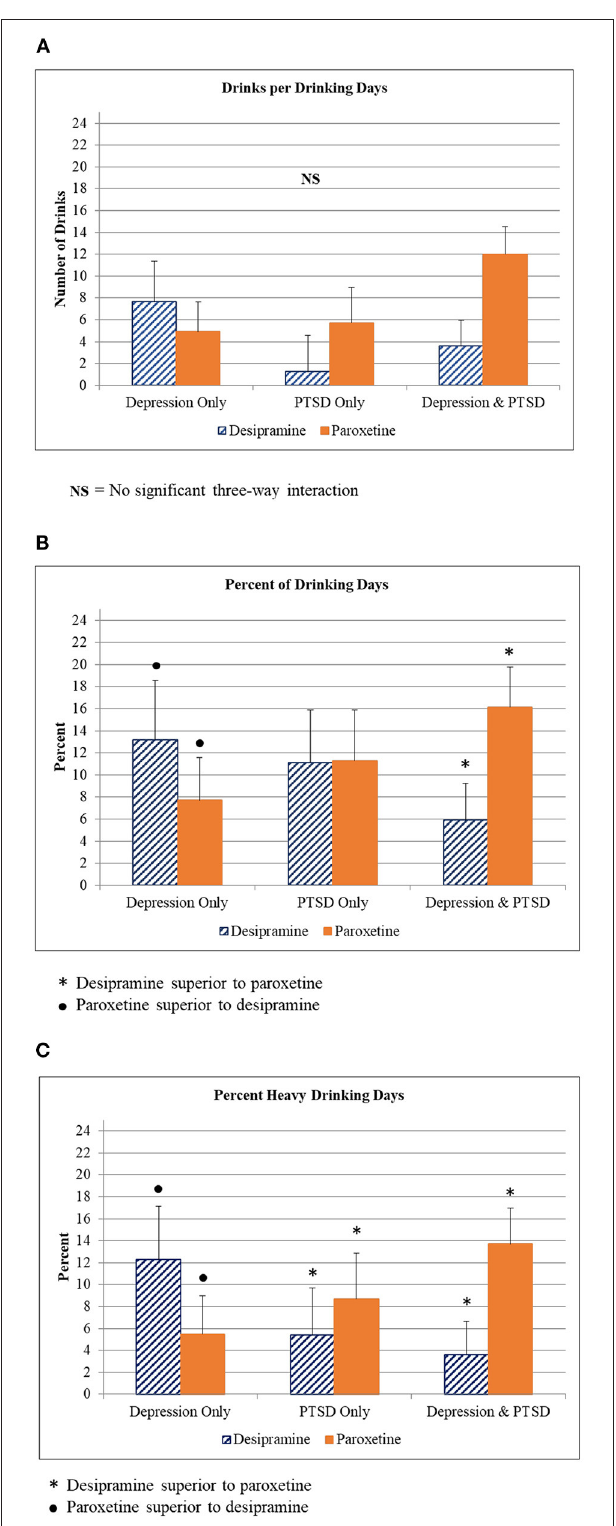
FIGURE 2 | Alcohol use outcomes by diagnostic group. (A) Drinks per drinking day for participants in each diagnostic group (Depression only, PTSD only, Depression + PTSD) who were given either desipramine or paroxetine.